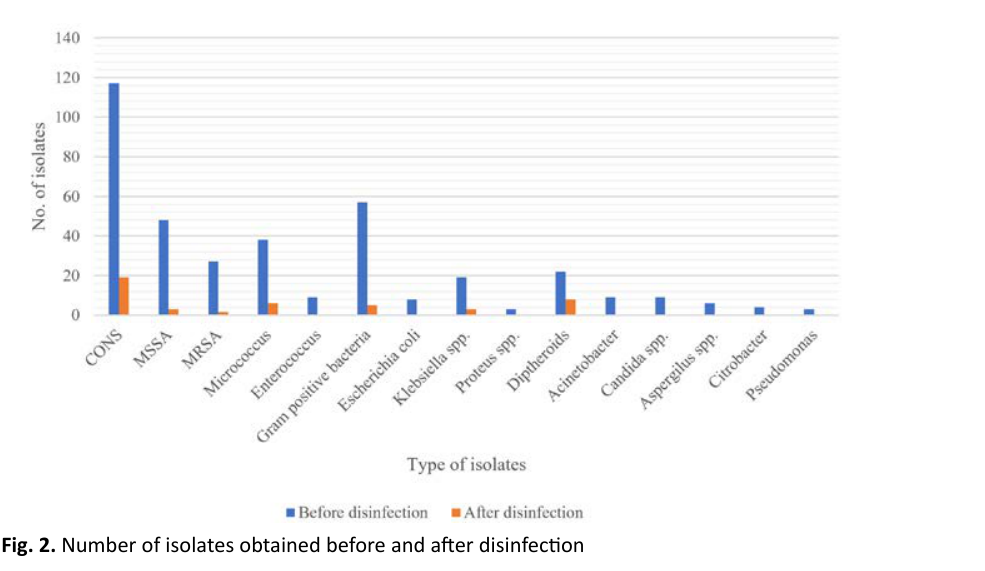
Fig. 2. Number of isolates obtained before and after Table 3. Microbial growth (number of samples) after disinfection with the reagents After Disinfection Disinfectant Stethoscopes not Stethoscopes Total showing colonization showing colonization